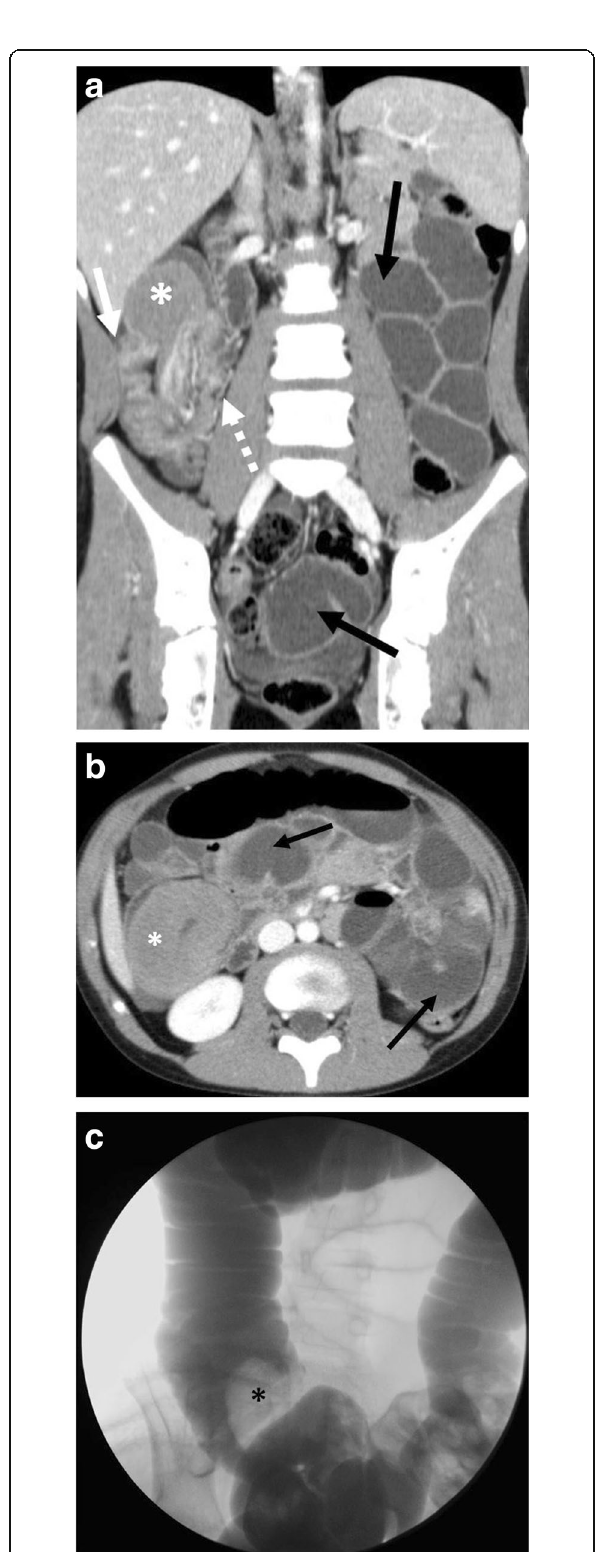
Fig. 2 Bowel involvement with intussusception. A 10-year-old male presenting to the emergency department with abdominal pain. a Coronal and ( b ) axial contrast enhanced CT images demonstrate ileo-colic intussusception with intussusceptum (dashed arrow) and intussuscipiens (solid arrow) and dilated, fluid-filled small bowel loops (black arrows) from an associated small bowel obstruction. Lead point mass (asterisks) is also seen. c Subsequent fluoroscopic-guided contrast reduction enema demonstrating filling defect (asterisks) corresponding to the lead point mass was ultimately unsuccessful. The patient underwent surgical resection with pathology demonstrating Burkitt